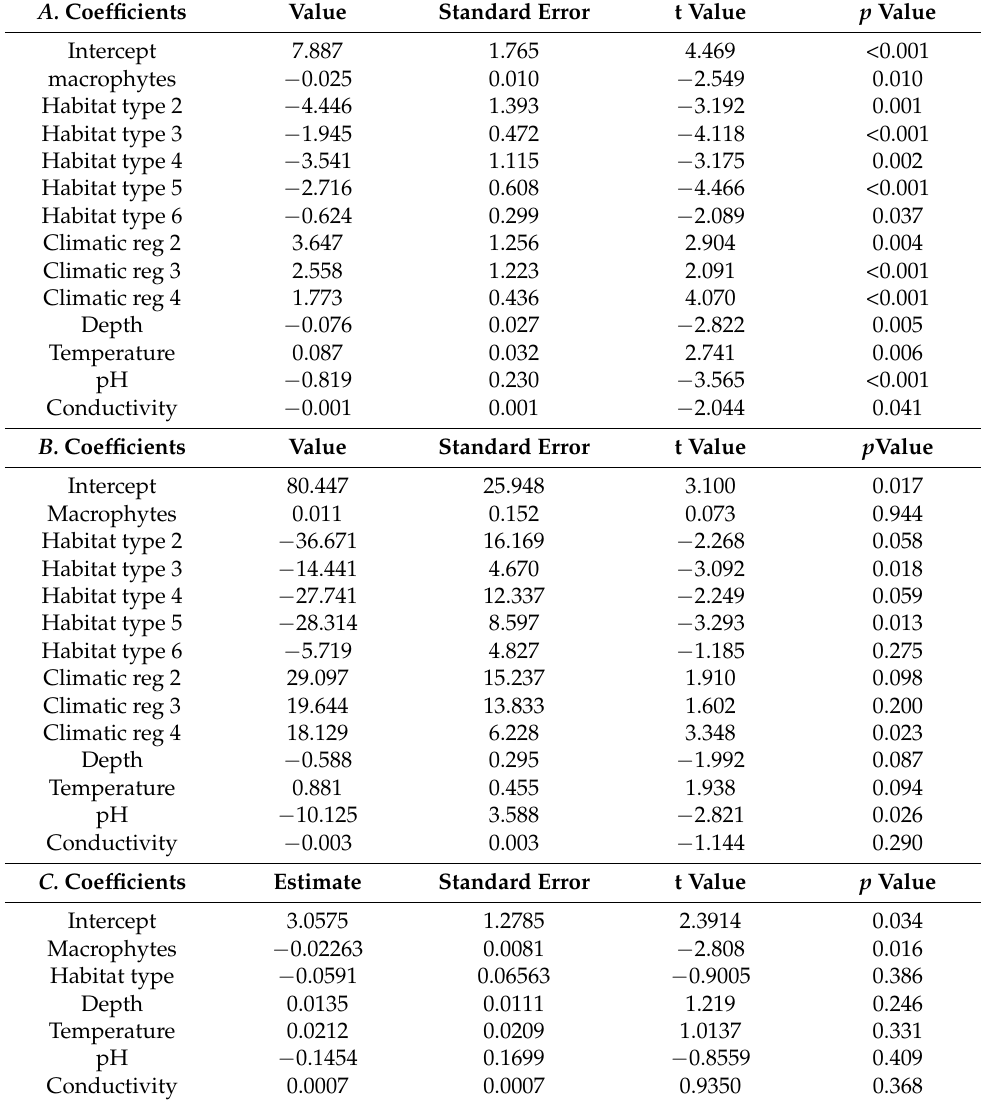
Table 4. Importance of environmental features in determining species richness (S) in 21 Kenyan waterbodies. A. Generalized linear model (GLM): S = macrophytes + habitat type + climatic region + depth + temperature + pH + conductivity. B. Generalized least squares fit (GLS) with Gaussian spatial correlations using the same model but accounting for longitude, latitude, and elevation. AIC = 117.9. C. Moran’s eigenvector with spatial filtering. Habitat types and climatic regions are defined in the